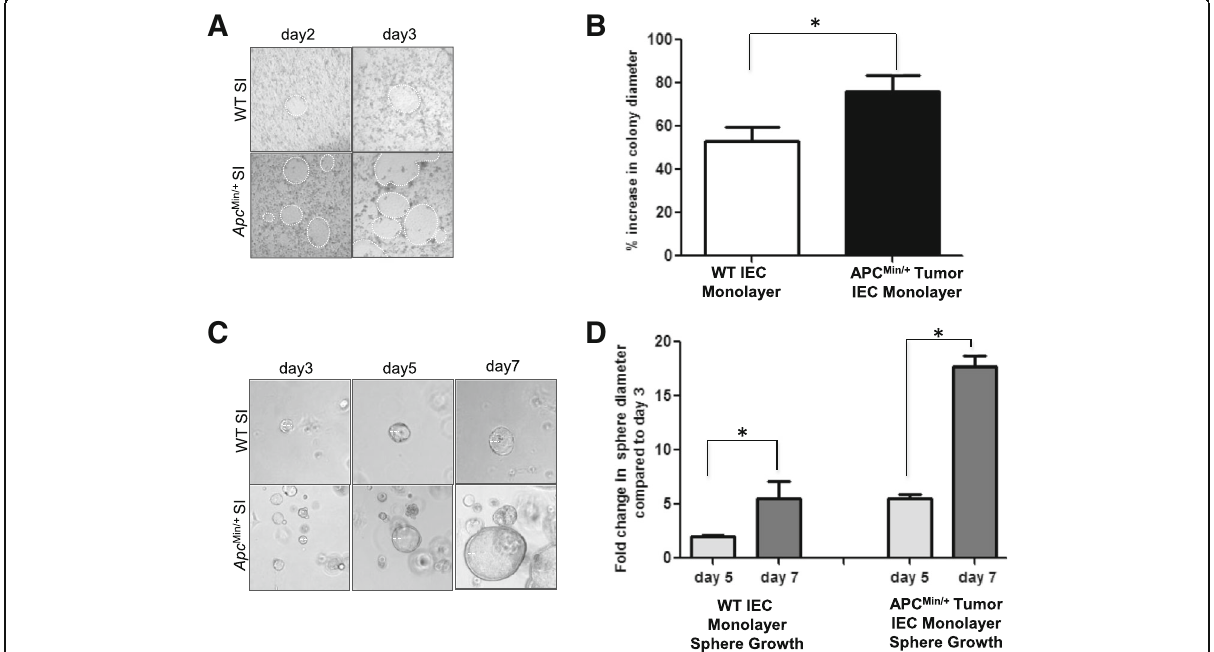
Fig. 5 Mouse Apc Min/+ tumor IEC monolayers retain functional characteristics of intestinal epithelium. a Representative images of WT and Apc Min/+ tumor IEC monolayers colonies growing on a feeder layer at passage 0. b Quantification of WT and Apc Min/+ tumor IEC monolayer colony growth between days 2 and 3 post-plating. c Representative images of WT and Apc Min/+ tumor IEC monolayer derived spheroids grown in matrigel. d Quantification of WT and Apc Min/+ tumor IEC monolayer derived spheroid growth based on spheroid diameter on day 5 and day 7 compared to day 3. * p < 0.05, n = 3 individual animals in each genetic mouse